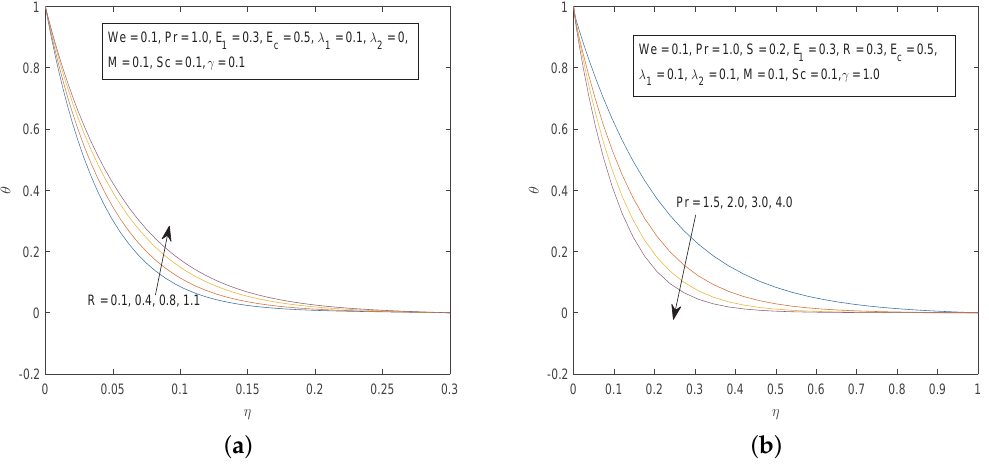
Figure 8. ( a ) Effects of R on θ and ( b ) Effects of Pr on θ